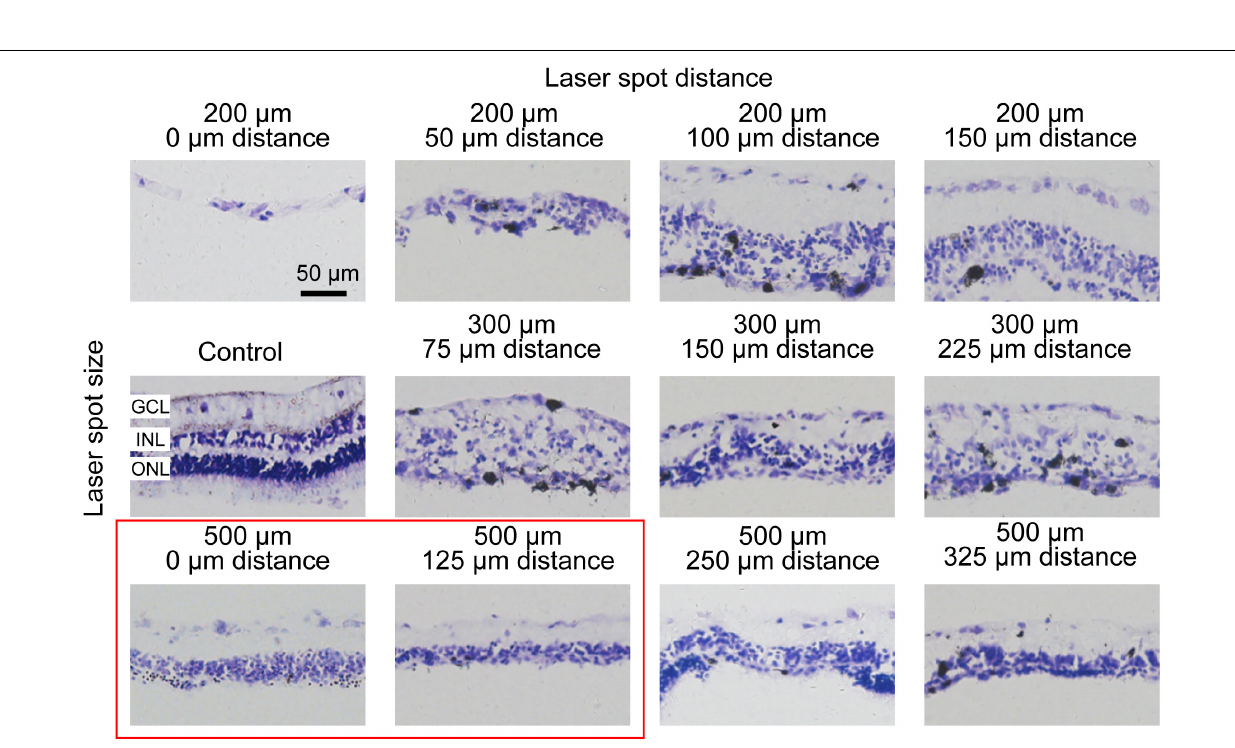
FIGURE 2 | Histomorphology of rabbit retinas 7 days after photocoagulation with 100 mW laser power. Nissl staining of rabbit retina with different pulse durations and laser spot sizes under 100 mW laser power. Each column corresponds to a constant laser spot size, and each row corresponds to a constant pulse duration. The better conditions are circled by the red box. GCL, ganglion cell layer; INL, inner nuclear layer; ONL, outer nuclear layer. Scale bar = 50 µ m.